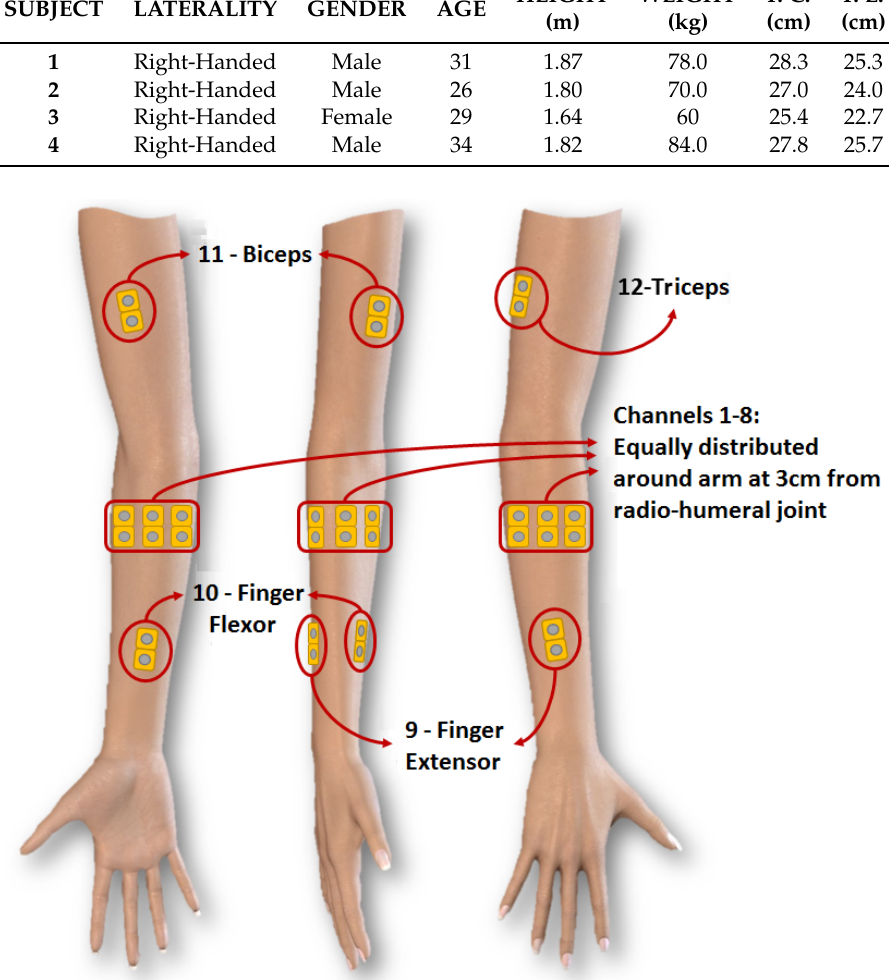
Figure 2. Electrode fixation (Cene et al.